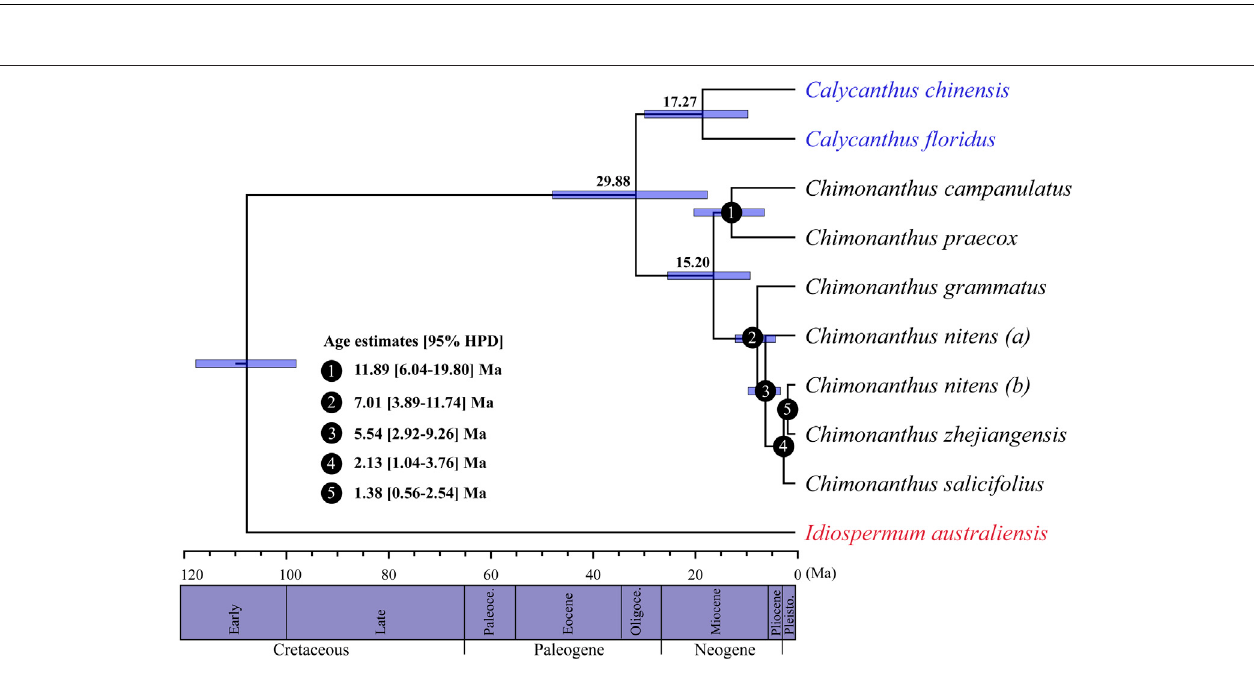
Frontiers in Genetics |